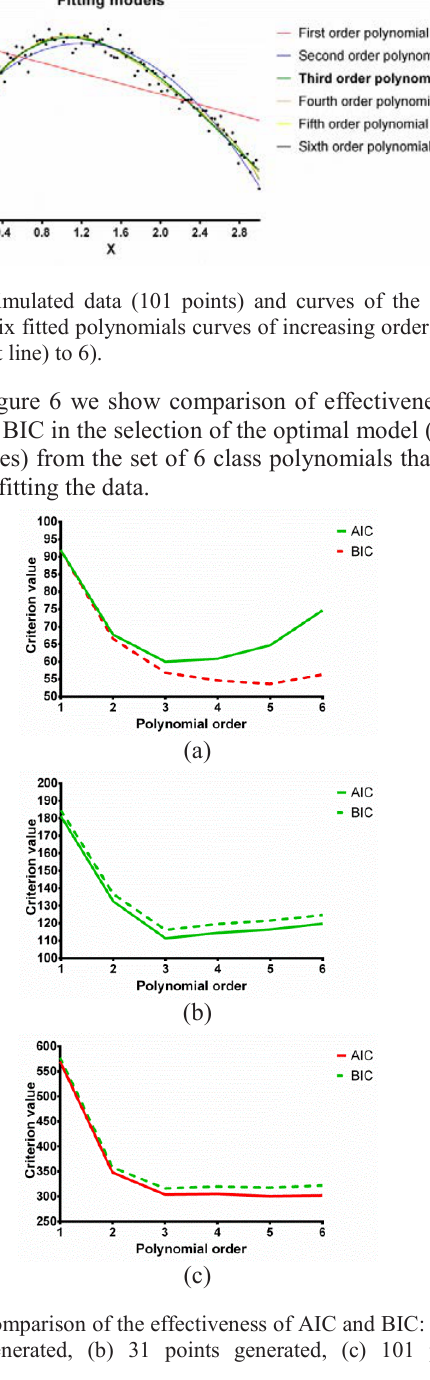
Fig. 3. Simulated data (15 points) and curves of the fitting models (six fitted polynomial curves of increasing order, from 1 (straight line) to 6).